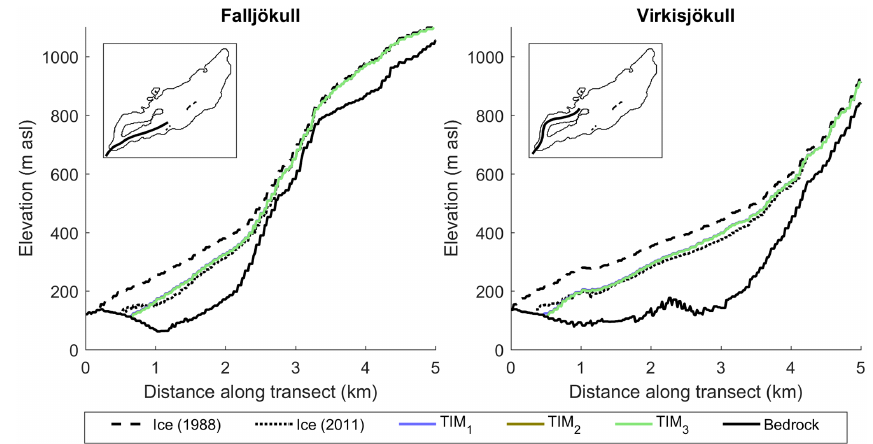
Figure 10. Observed and simulated ice thickness change as measured along the transects of the Falljökull and Virkisjökull glacier arms. Insets show transect locations.